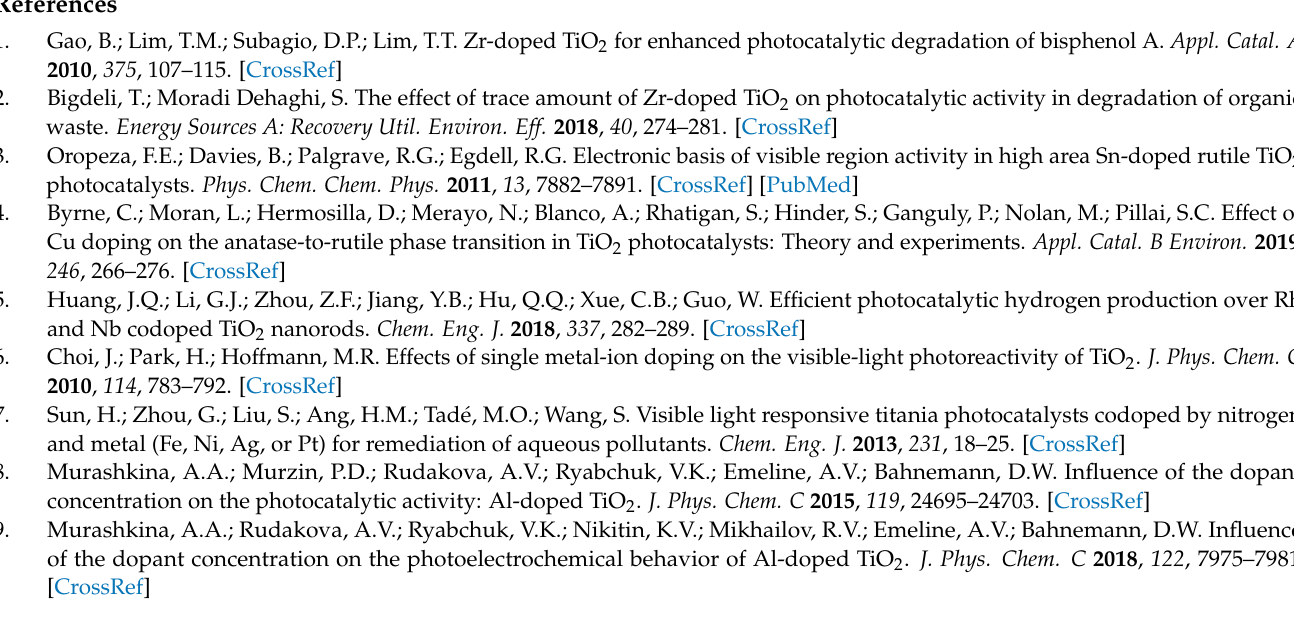
Figure S1: Diffuse reflectance spectra before and after UV irradiation of undoped and doped TiO 2 ; Figure S2: EPR spectra of pristine and doped TiO 2 ; Figure S3: Integrated EPR spectra of Sc-doped TiO 2 ; Figure S4: XRD pattern of Sc- and Nb-doped TiO 2 samples; Figure S5: Electron microscopic images of undoped and doped TiO 2 ; Figure S6: XPS spectra of Sc- and Nb-doped TiO 2 samples; Figure S7: Transmittance spectra of BS-6 cut-off and UFS-2 bandpass filters; Figure S8: Diffuse reflectance spectra and Tauc plot transformation of Sc- and Nb-doped TiO 2